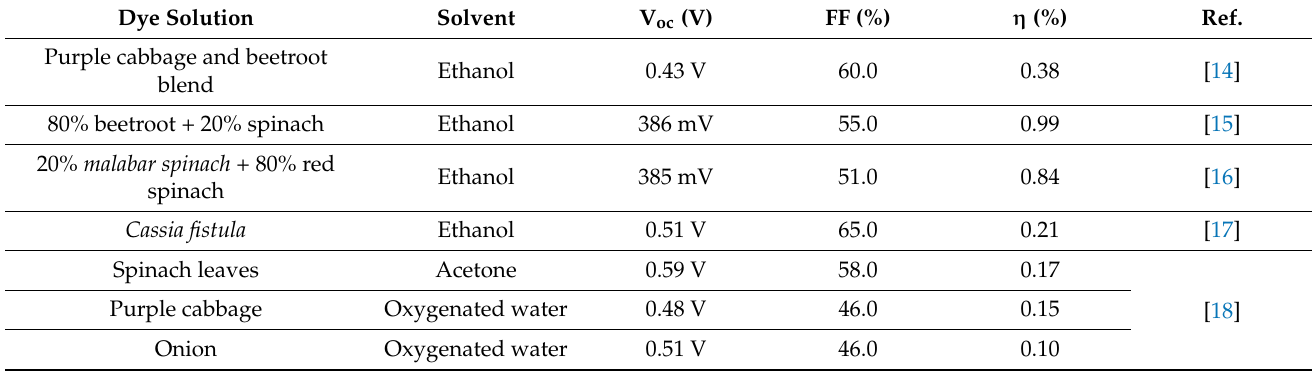
Table 1. Performances of DSSCs using natural